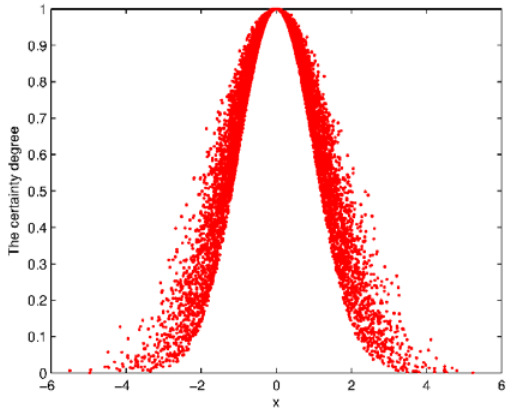
Figure 1. Normal cloud